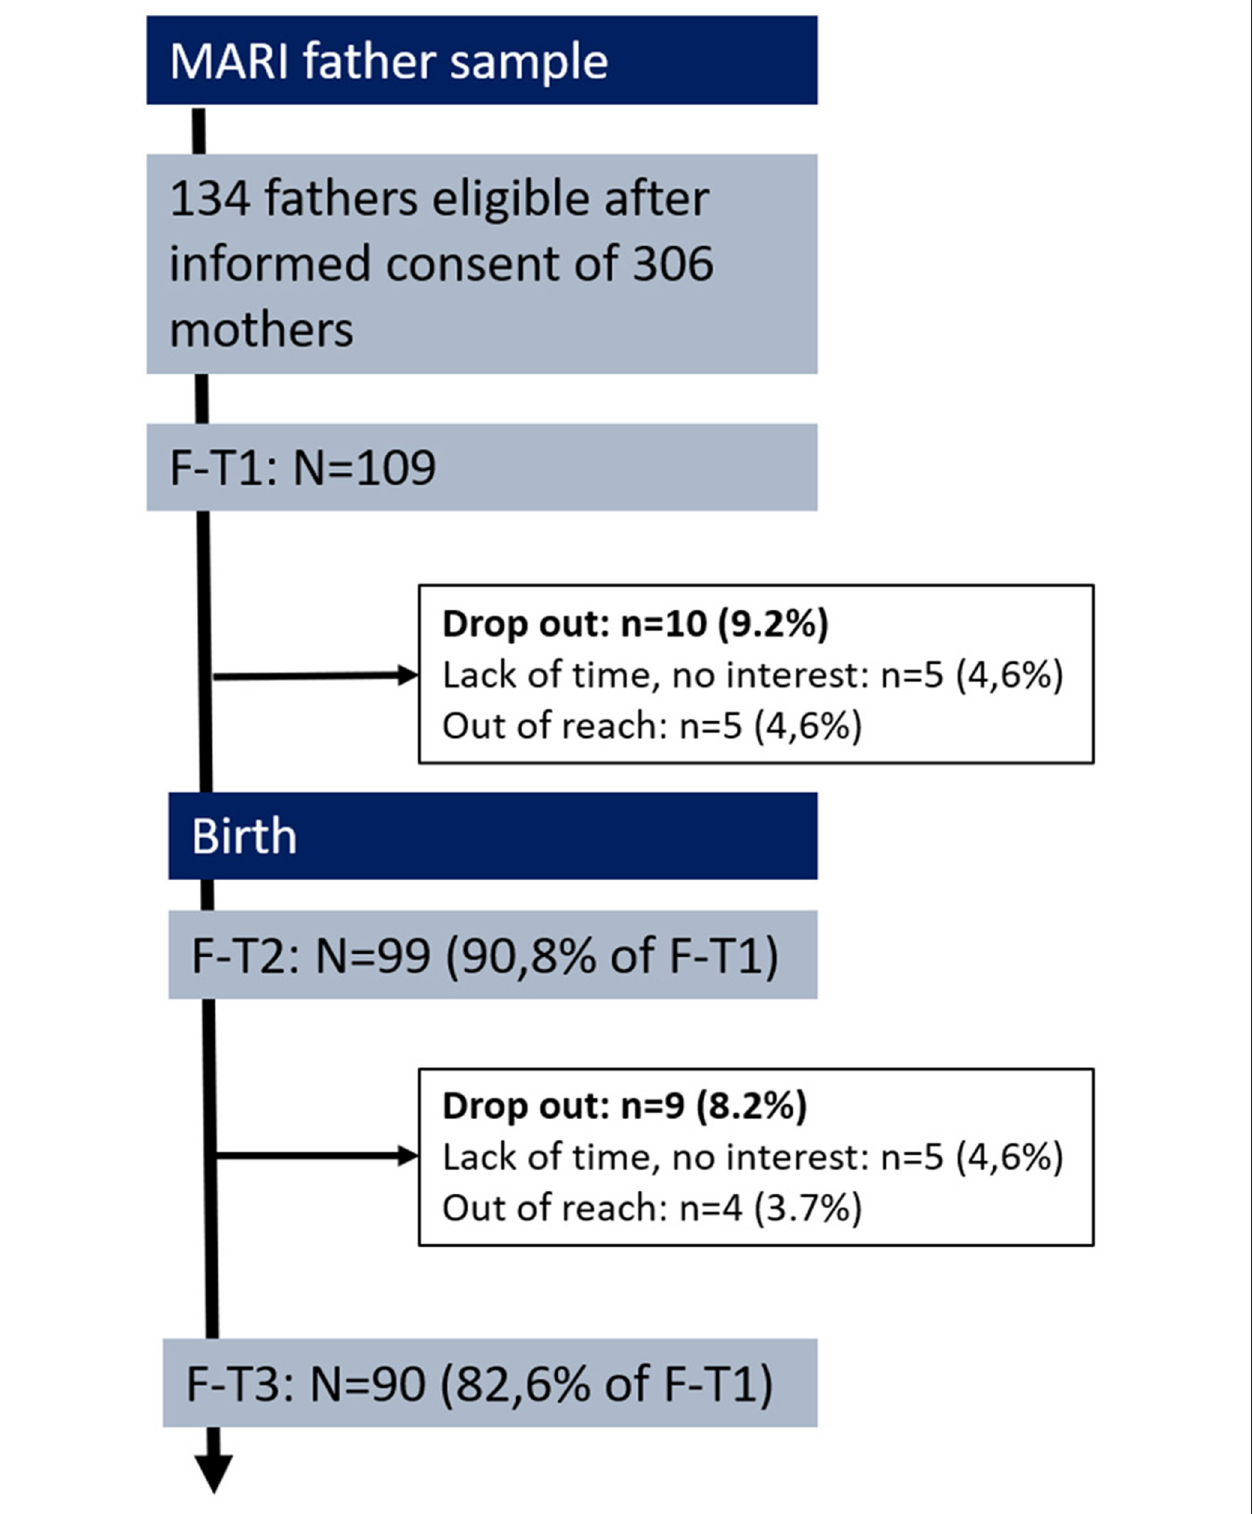
FIGURE 1 | Flow chart and retension rates of the MARI father study. F-T1 week 22 to 24 of gestation, F-T2 at 10 days postpartum, F-T3 at 4 months postpartum.